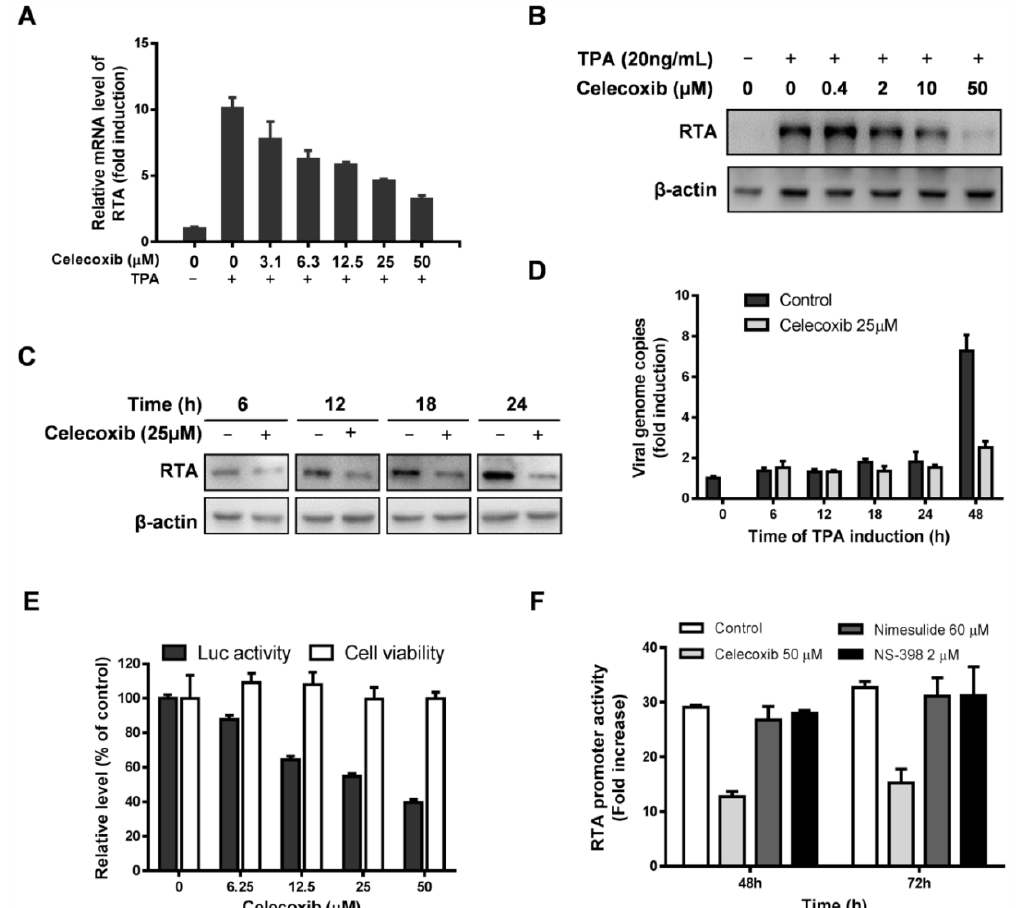
Figure 5. Celecoxib suppresses RTA expression through an off-target effect. The levels of RTA mRNA ( A ) and protein expression ( B ) in BCBL-1 treated with celecoxib were determined by WB and RT-qPCR at 72 h after TPA induction respectively. All transcripts of mRNA were normalized to actin gene; ( C ) The effect of celecoxib (25 µM) on RTA expression in BCBL-1 at various time points post TPA induction were determined by WB assay using specific antibodies; ( D ) Kinetics of KSHV genome replication in the presence or absence of celecoxib following TPA induction. The copy number of KSHV genomes was detected by qPCR. Data were normalized as the fold change compared to the TPA un-induced control; ( E ) HEK293 cells co-transfected with pGL3-RTA, pCR3.1-ORF50 and pRL-TK (25:25:1) were treated with various concentrations of celecoxib and the luciferase activity (black bars) was analyzed at 48 h. In parallel with the luciferase assay, the cytotoxicity of HEK293 (grey bars) was determined by CellTiter-Glo ® Luminescent Cell Viability Assay; ( F ) HEK293 co- transfected with pGL3-RTA, pCR3.1-ORF50 and pRL-TK in the presence of test compounds was determined by the luciferase activity at (48 h and 72 h). Data were normalized as the relative luciferase activity compared to the DMSO control. The results are presented as the mean values with standard deviations ( n =